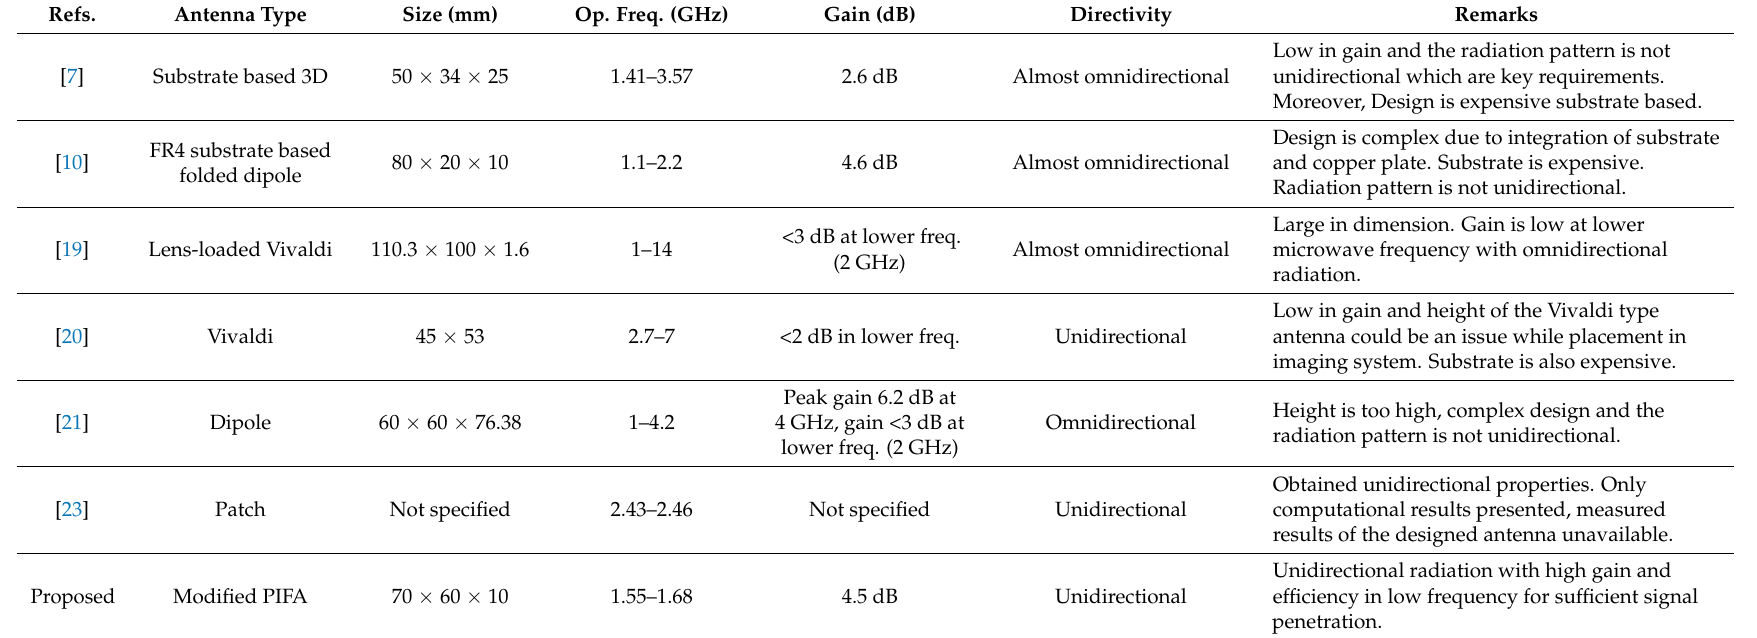
Table 2. Comparison with other